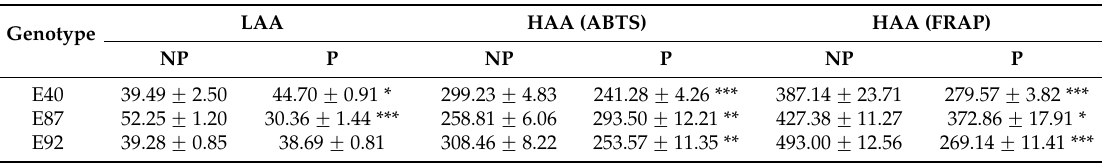
Table 5. Antioxidant activities in yellow tomato lines before (NP) and after (P) processing evaluated by ABTS and FRAP